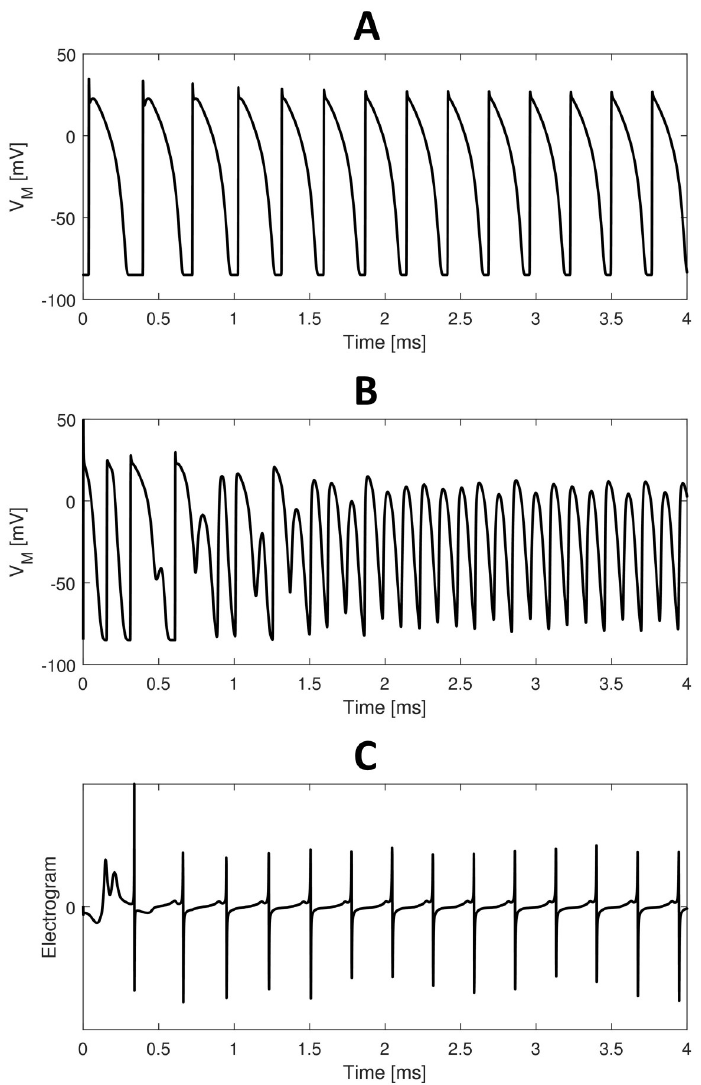
Fig 7. Membrane potentials and electrograms during reentry dynamics. (A) Membrane potential recorded in a point far from the tip (asterisk in Fig 8A). (B) Membrane potential recorded at the center of the spiral core (circle in Fig 8A). (C) Simulated electrogram. Time axis indicates time after S2 stimulus